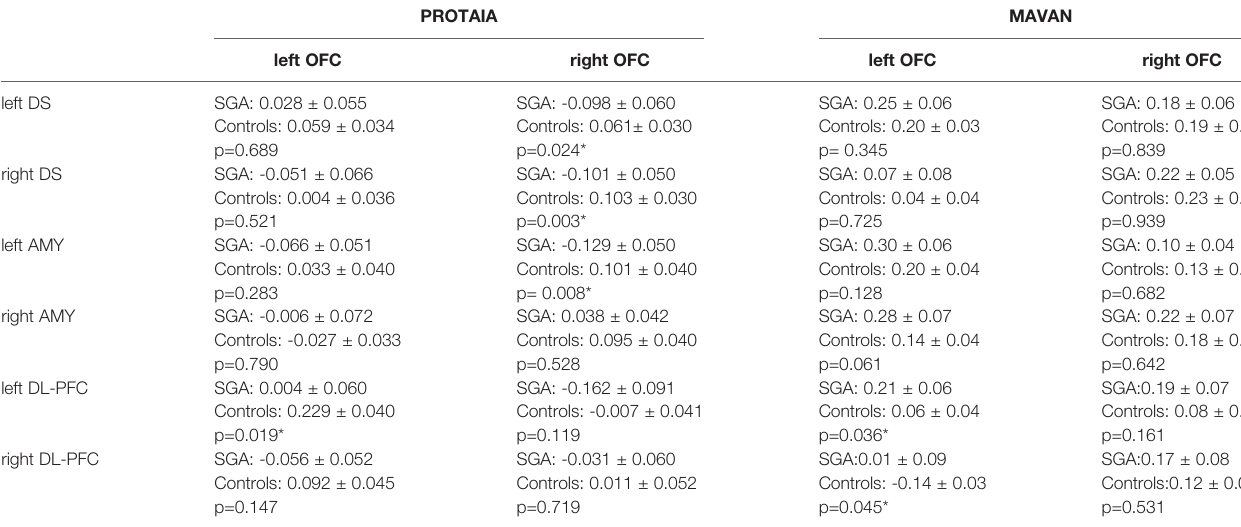
TABLE 3 | SGA versus controls rs-FC between orbitofrontal cortex (left and right) and ROIs with signi fi cant results in one of the cohorts.